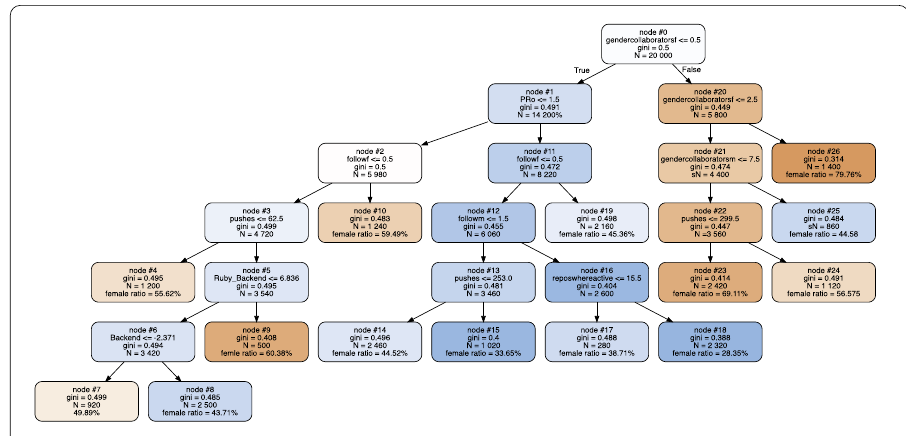
Figure 7 Decision Tree model for gendered constellations of behavioral variables. Our final tree (minimum samples split = 1000, max depth = 10, test size = 0.6) resulted with a 0.6327 AUC and 14